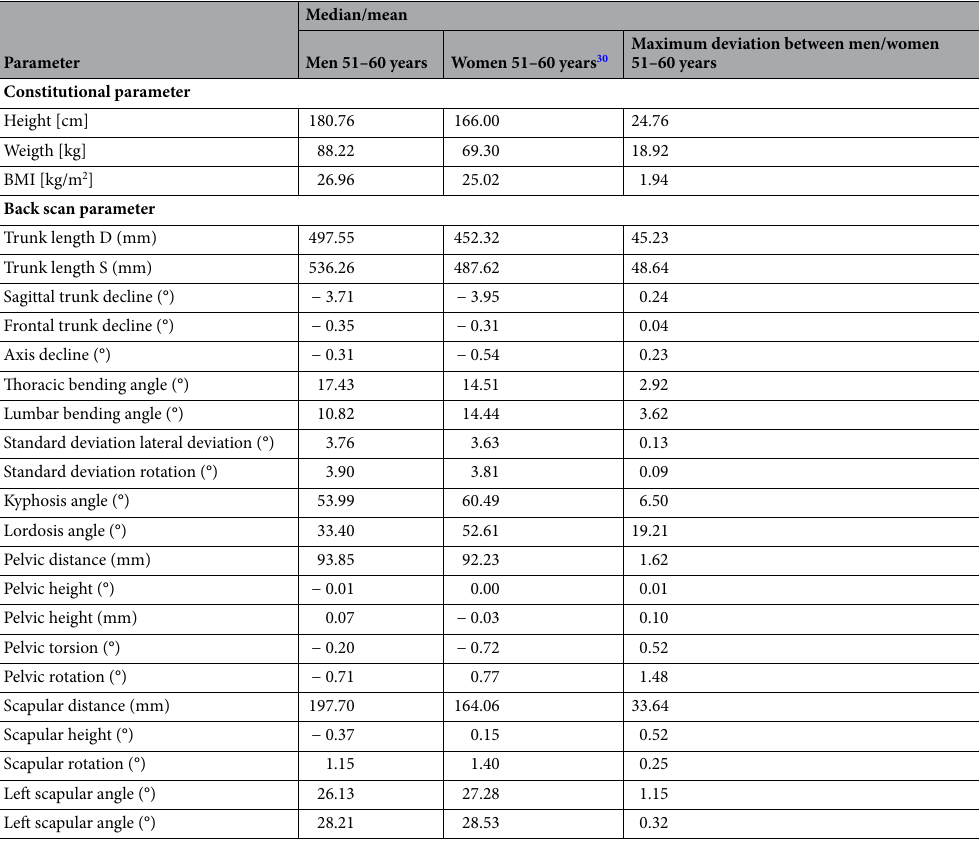
Table 4. Comparison of the median and mean values of the constitutional parameters and back parameters of males and females in the age group 51 to 60 years from the research of Ohlendorf et al. Values are taken from this work and research papers 30